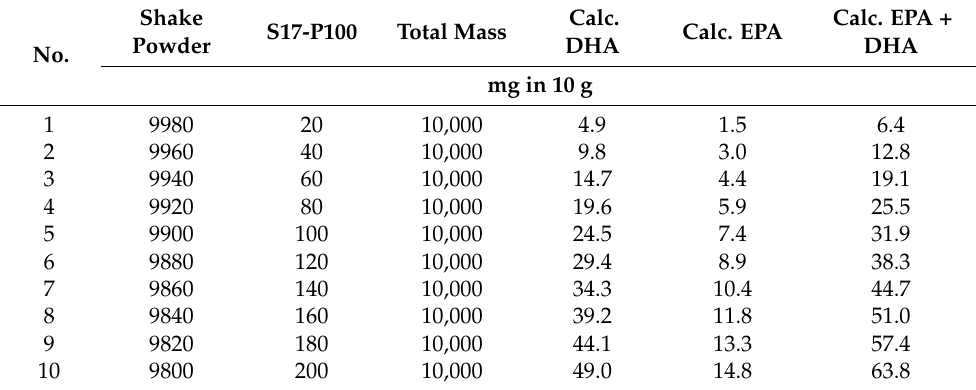
Table 4. The graded food additive enrichment protocol (product